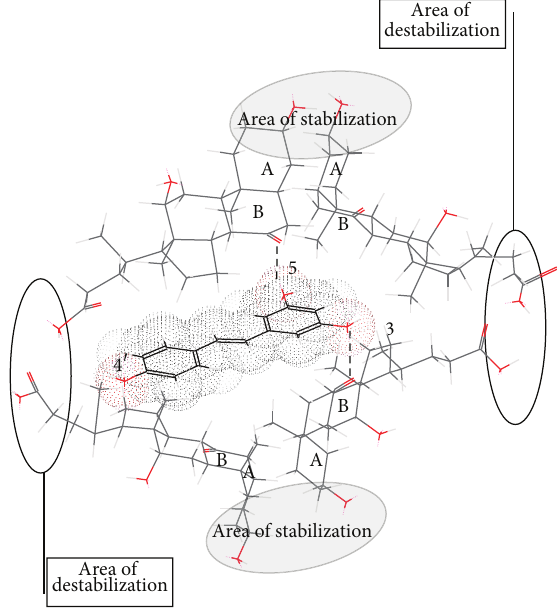
Figure 3: Mixed micelle of resveratrol and sodium 3 𝛼 ,12 𝛼 - dihydroxy-7-oxo-5 𝛽 -cholanoate (dotted lines depict hydrogen